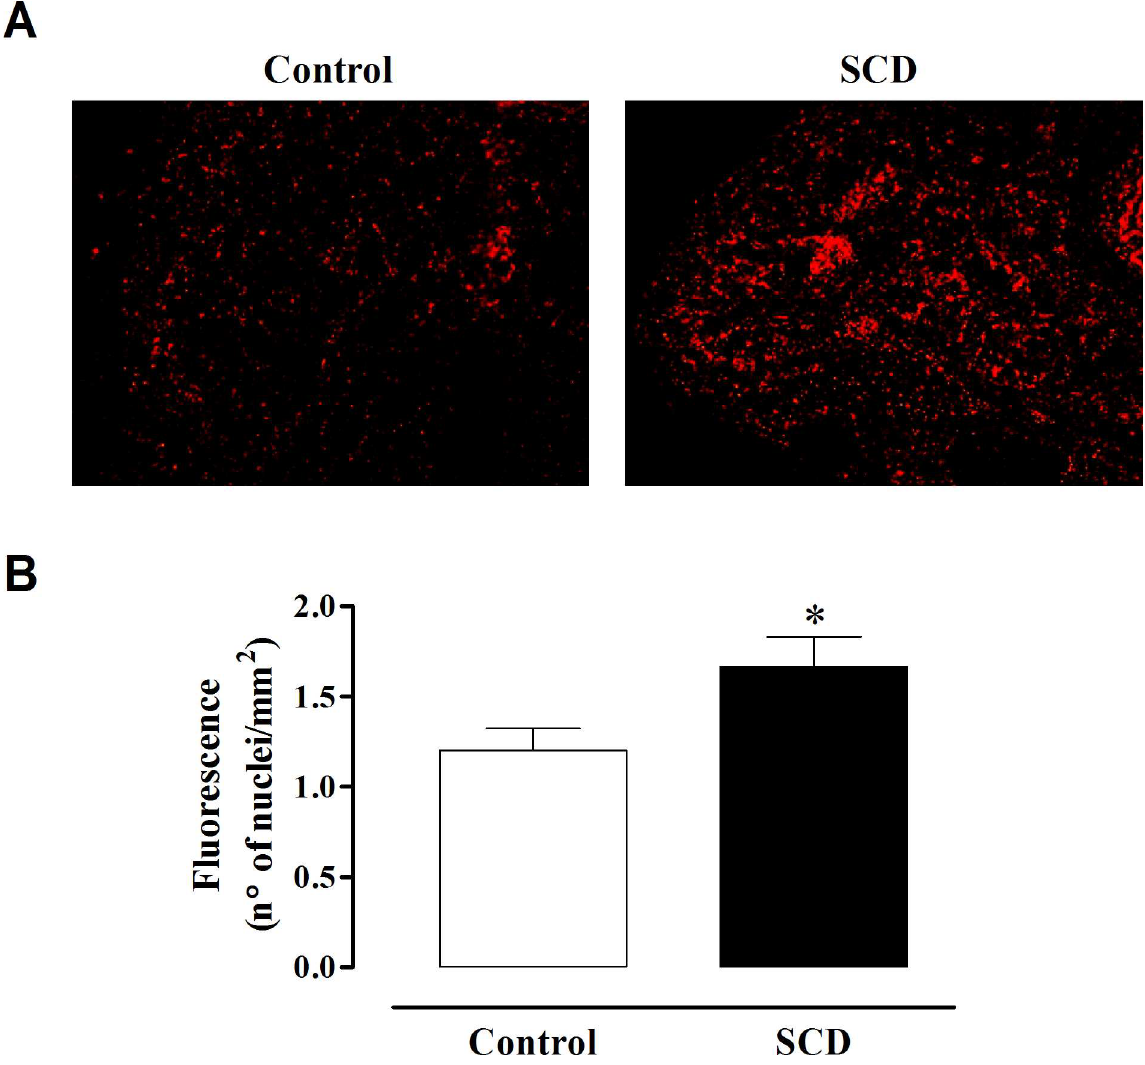
Fig 6. Reactive-oxygen species levels through hydroethidine-induced fluorescence in corpus cavernosum from control and SCD mice. ( A ) Representative and ( B ) quantitative analysisfor hydroethidine-fluorescence photomicrographsof microscopic sections of corpus cavernosum. Data represent the mean ± SEM of 6 mice in each group. Singleasterisk indicatesp < 0.05 vs control group. (Student’sunpaired t